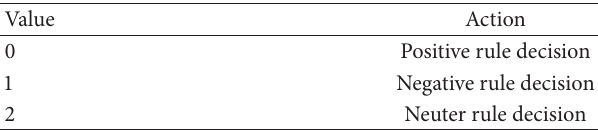
Table 1: States for a candidate term. Table 2: Actions for a candidate term.